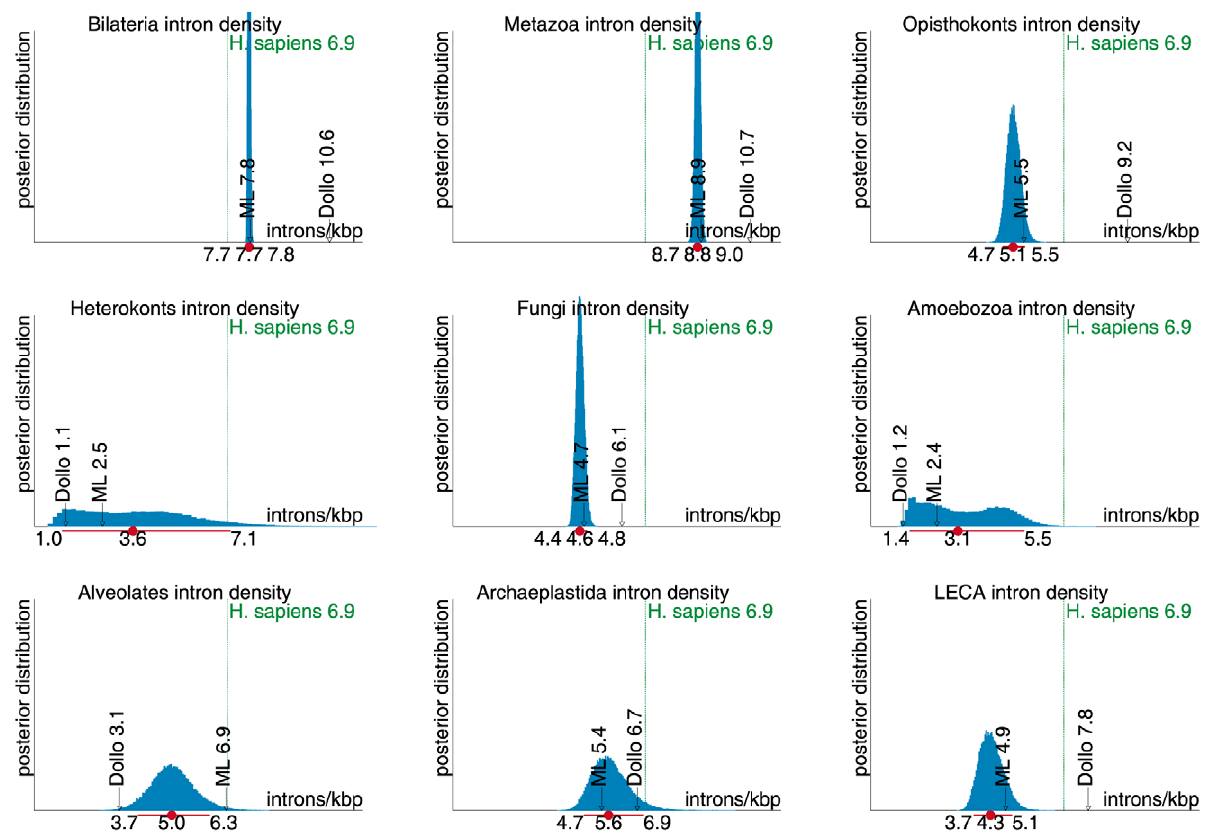
Figure 2. Inferred ancestral intron densities and confidence intervals. The plots for 9 key ancestral forms show the posterior distributions of the ancestral intron density inferred from the sampling chains. On each plot, the horizontal red line shows the median (the dot) and the 95% ( + / 2 47.5%) confidence interval around it, estimated from 50,000 sampled MCMC steps.